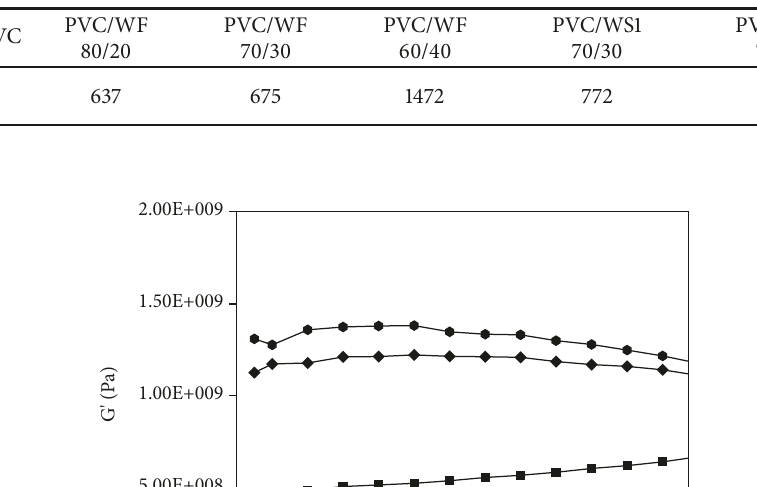
Table 5: The Young modulus of PVC/WF composites.